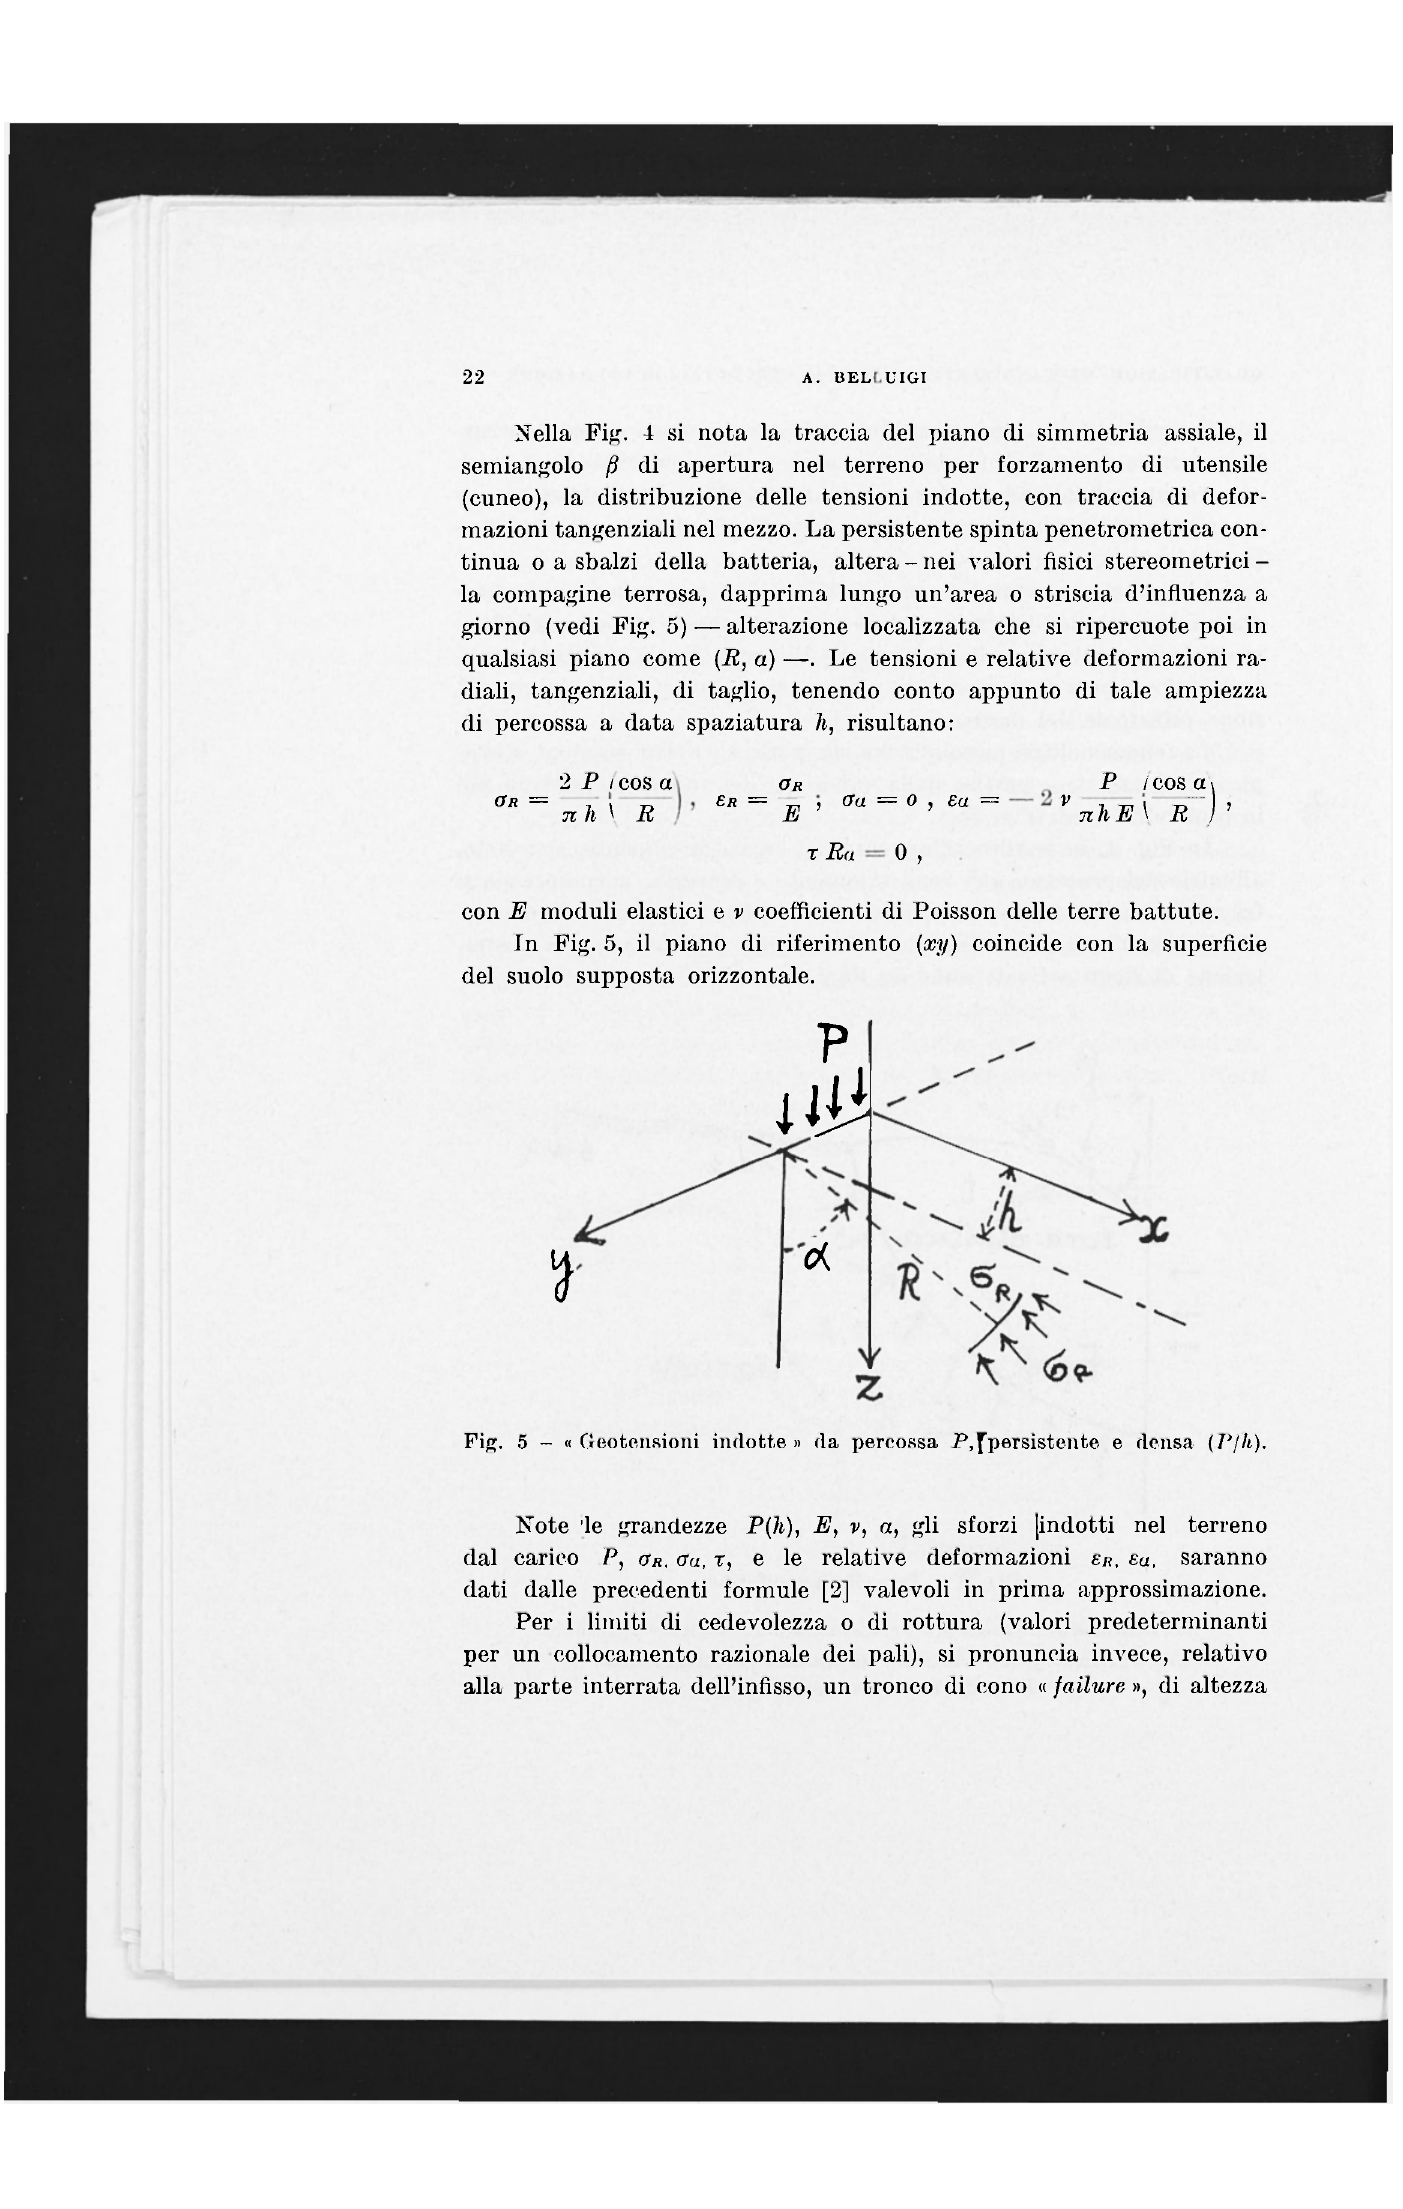
Fig. 5 - « Geotensioni indotte » da percossa P,^persistente e densa